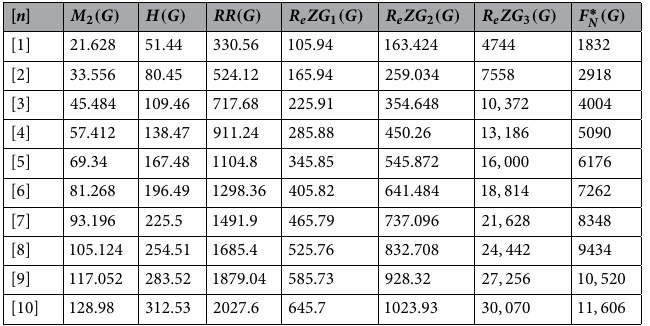
Table 3. Comparison of M 2 ( G ) , H ( G ) , RR ( G ) , R e ZG 1 ( G ) , R e ZG 2 ( G ) , R e ZG 3 ( G ) and F ∗ N ( G ) for ZNOX .